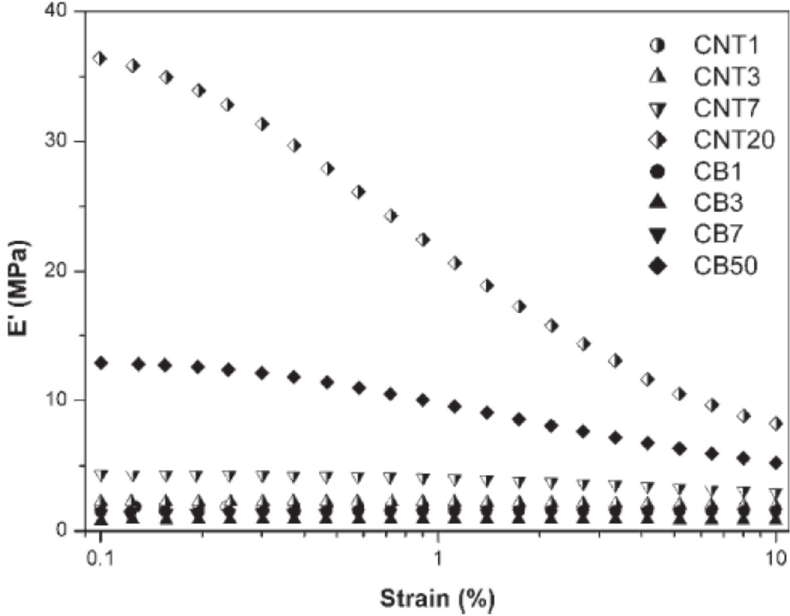
Figure 21. Storage modulus of NR/CNT and NR/CB compounds at different filler loadings as a function of dynamic strain amplitude. Reproduced with permission from [170], Copyright Wiley, 2010.